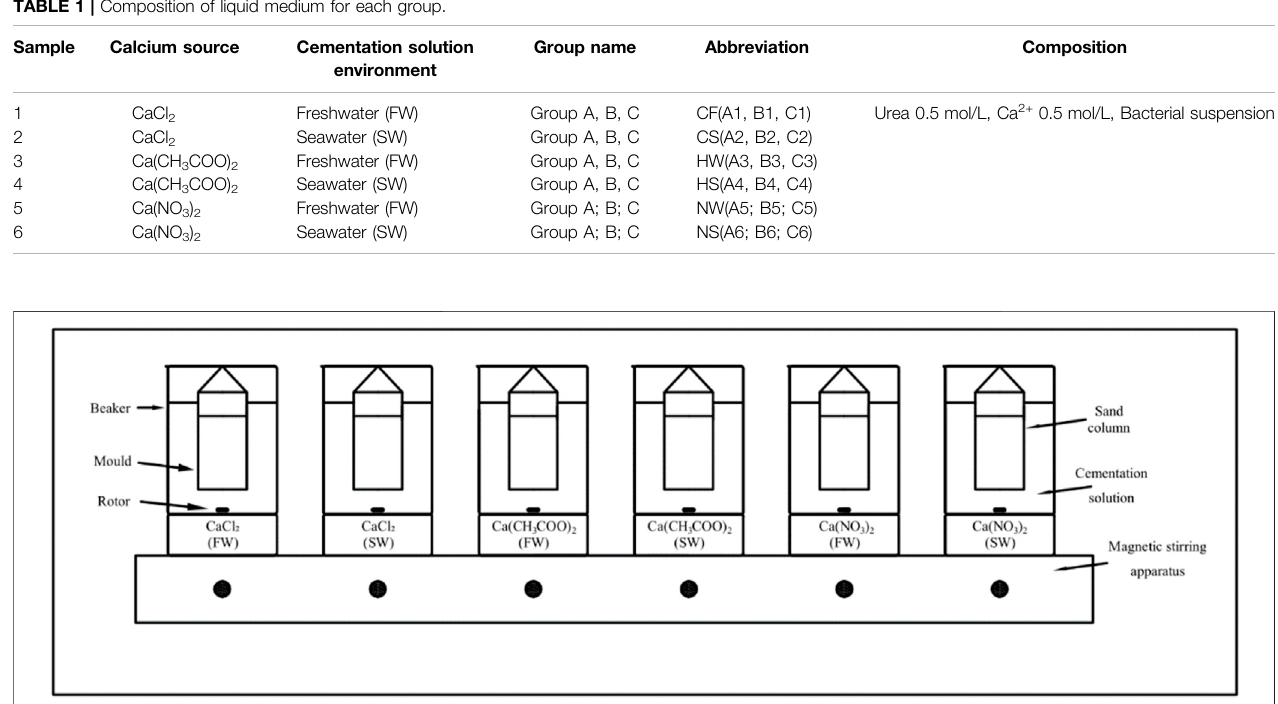
FIGURE 1 | Schematic diagram of reinforcement